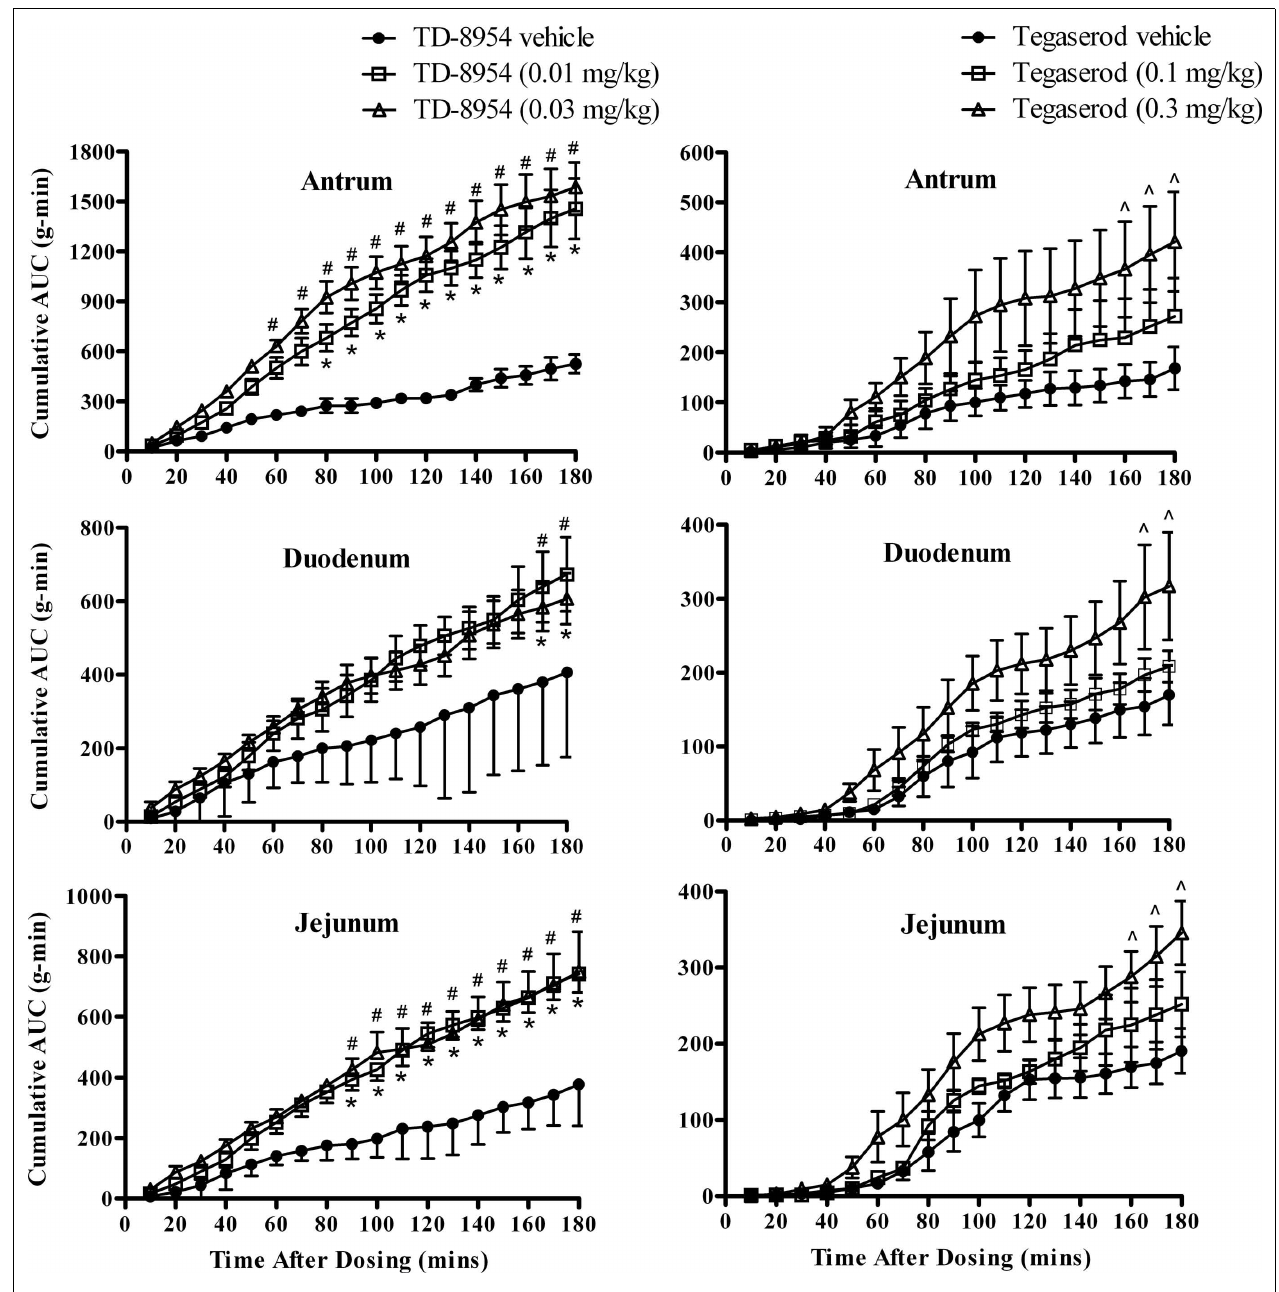
cumulative contractile AUC in 10-min periods for 3h post-dosing (at 0min). Data are analyzed using a two-way analysis of variance with a Bonferroni post hoc test (* ,# p < 0.05 for the 0.01, 0.03, and 0.3mg/kg treatment groups, respectively, vs.